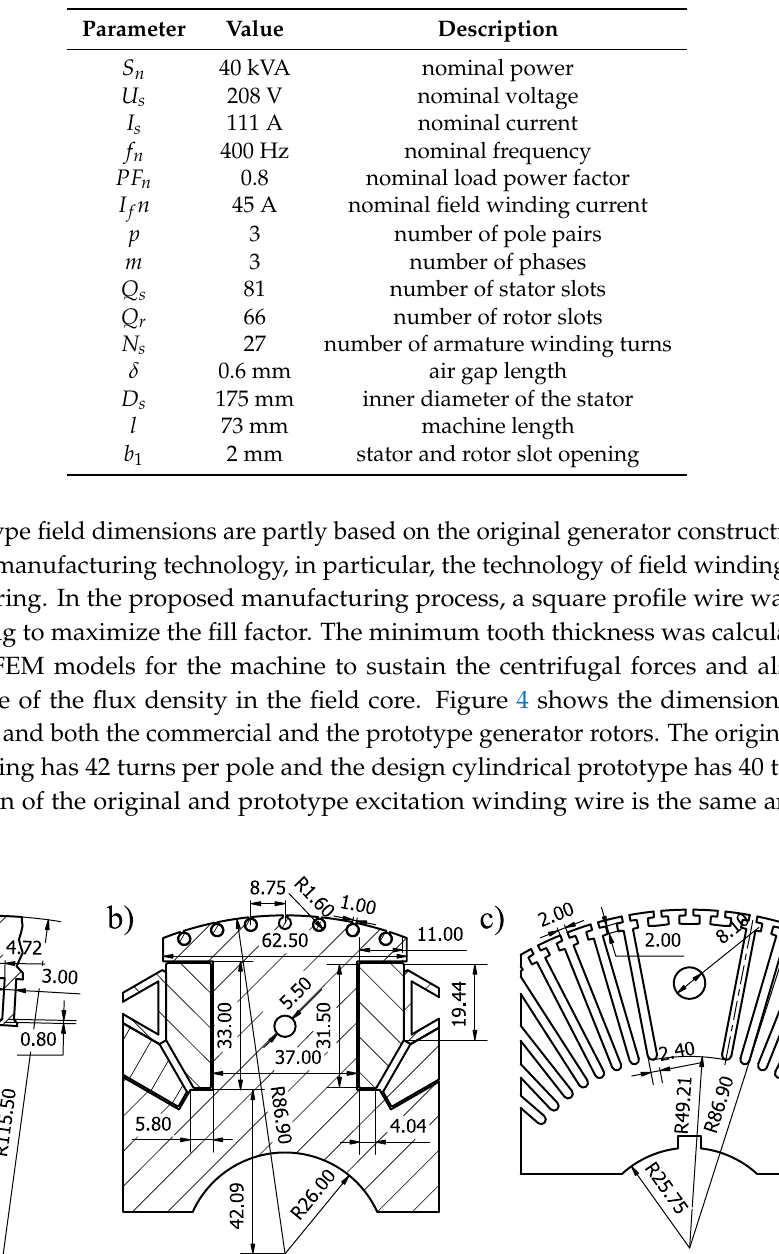
Table 1. Assumptions for the main generator stage design process.